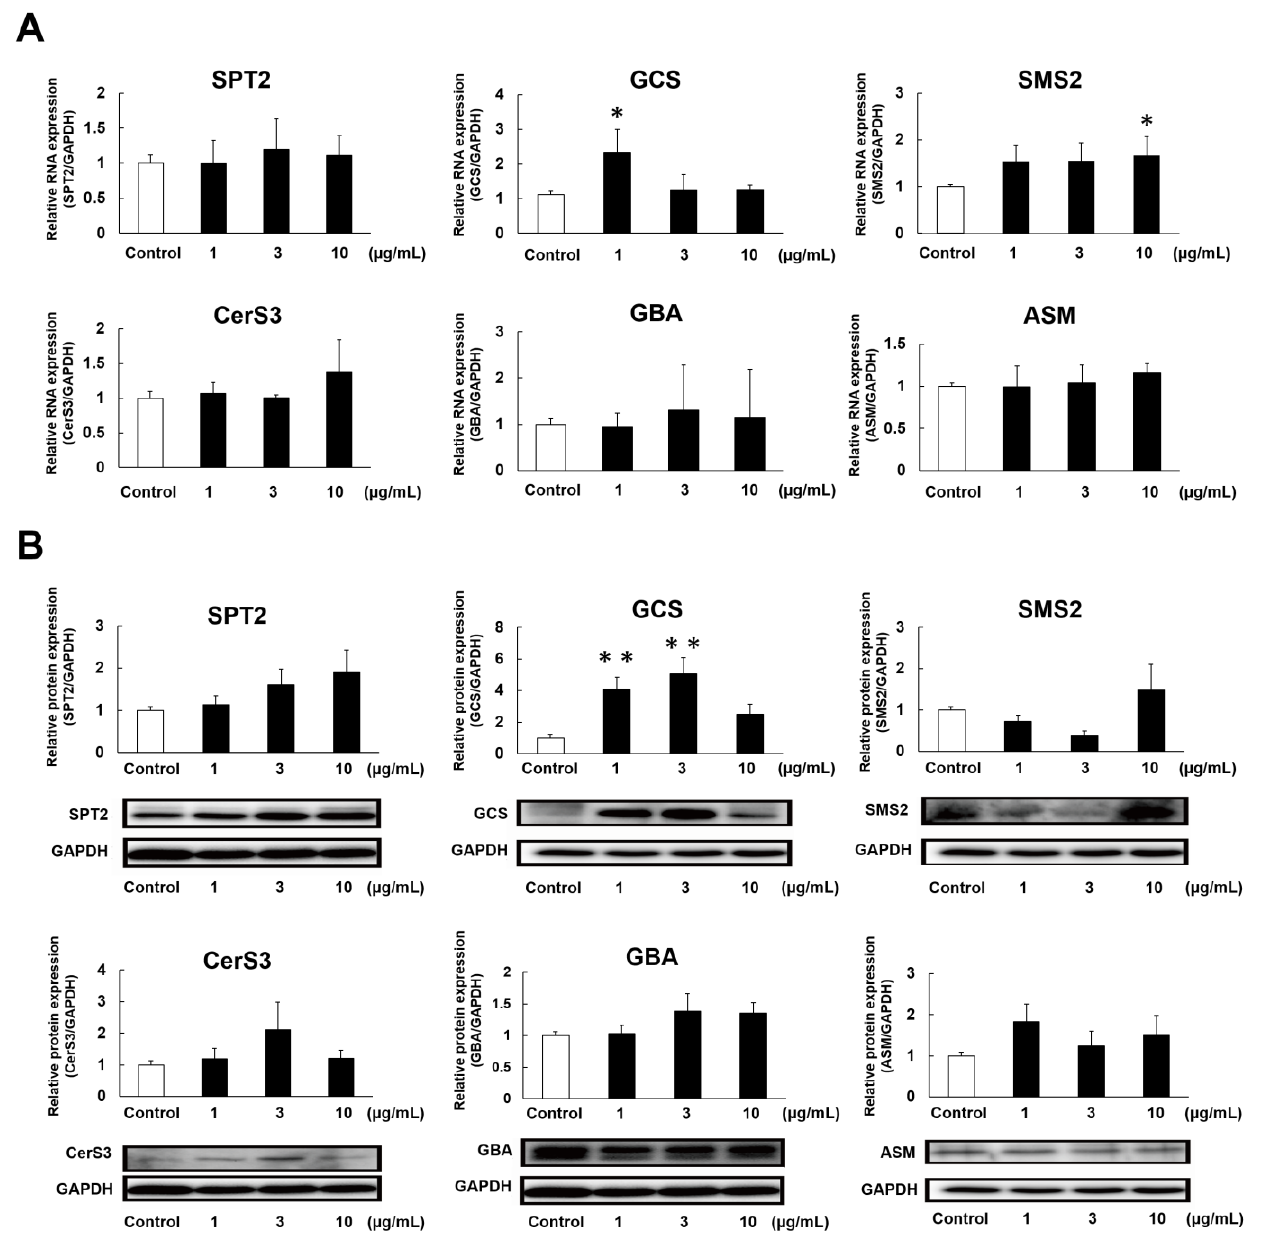
Figure 6. Effects of elasticamide ( 14 ) on the mRNA ( A ) and protein ( B ) expression of enzymes related to SC Cer synthesis. The RHEK model was treated for 2 days (for real-time RT-PCR) or 7 days (for Western blotting) with 14 (1 – 10 µg/mL). Real-time RT-PCR and a Western blotting analysis were performed as described in the Materials and Methods section. Data are expressed as means ± S.E. (n = 4). Asterisks denote a significant difference from the control group, * p < 0.05, ** p <